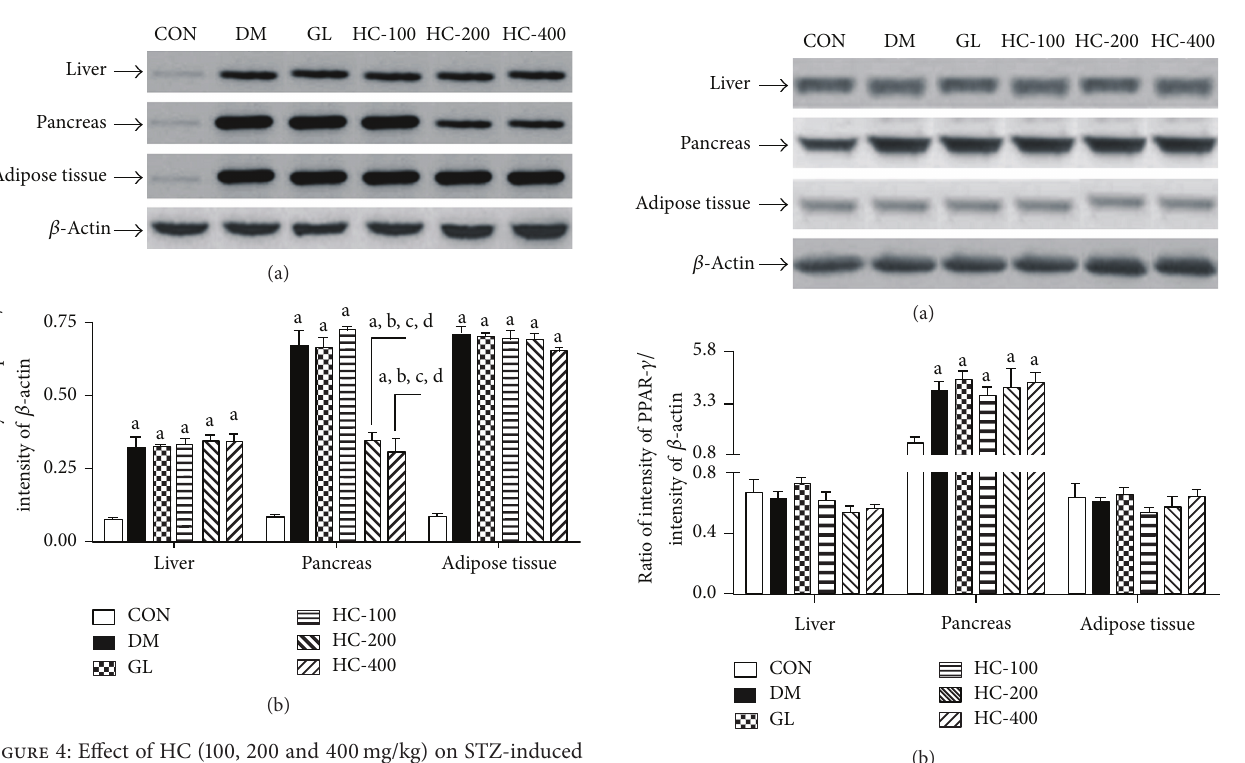
Figure 4: Effect of HC (100, 200 and 400mg/kg) on STZ-induced changesinthelevelsofexpressionofcaspase-3inliver,pancreas,and adipose tissues. The blots (a) are representative of caspase-3 in liver, pancreas, and adipose tissues. The results in the histogram (b) are expressed as ratio of relative intensity of levels of protein expression of caspase-3 to 𝛽 -Actin. All values are mean ± SEM of three separate sets of independent experiments. a 𝑃 < 0.05 compared to normal control; b 𝑃 < 0.05 compared to diabetic control; c 𝑃 < 0.05 compared to glibenclamide; d 𝑃 < 0.05 compared to HC 100; e 𝑃 < 0.05 compared to HC 200 (One-way ANOVA followed by Tukey’s multiple comparison test).